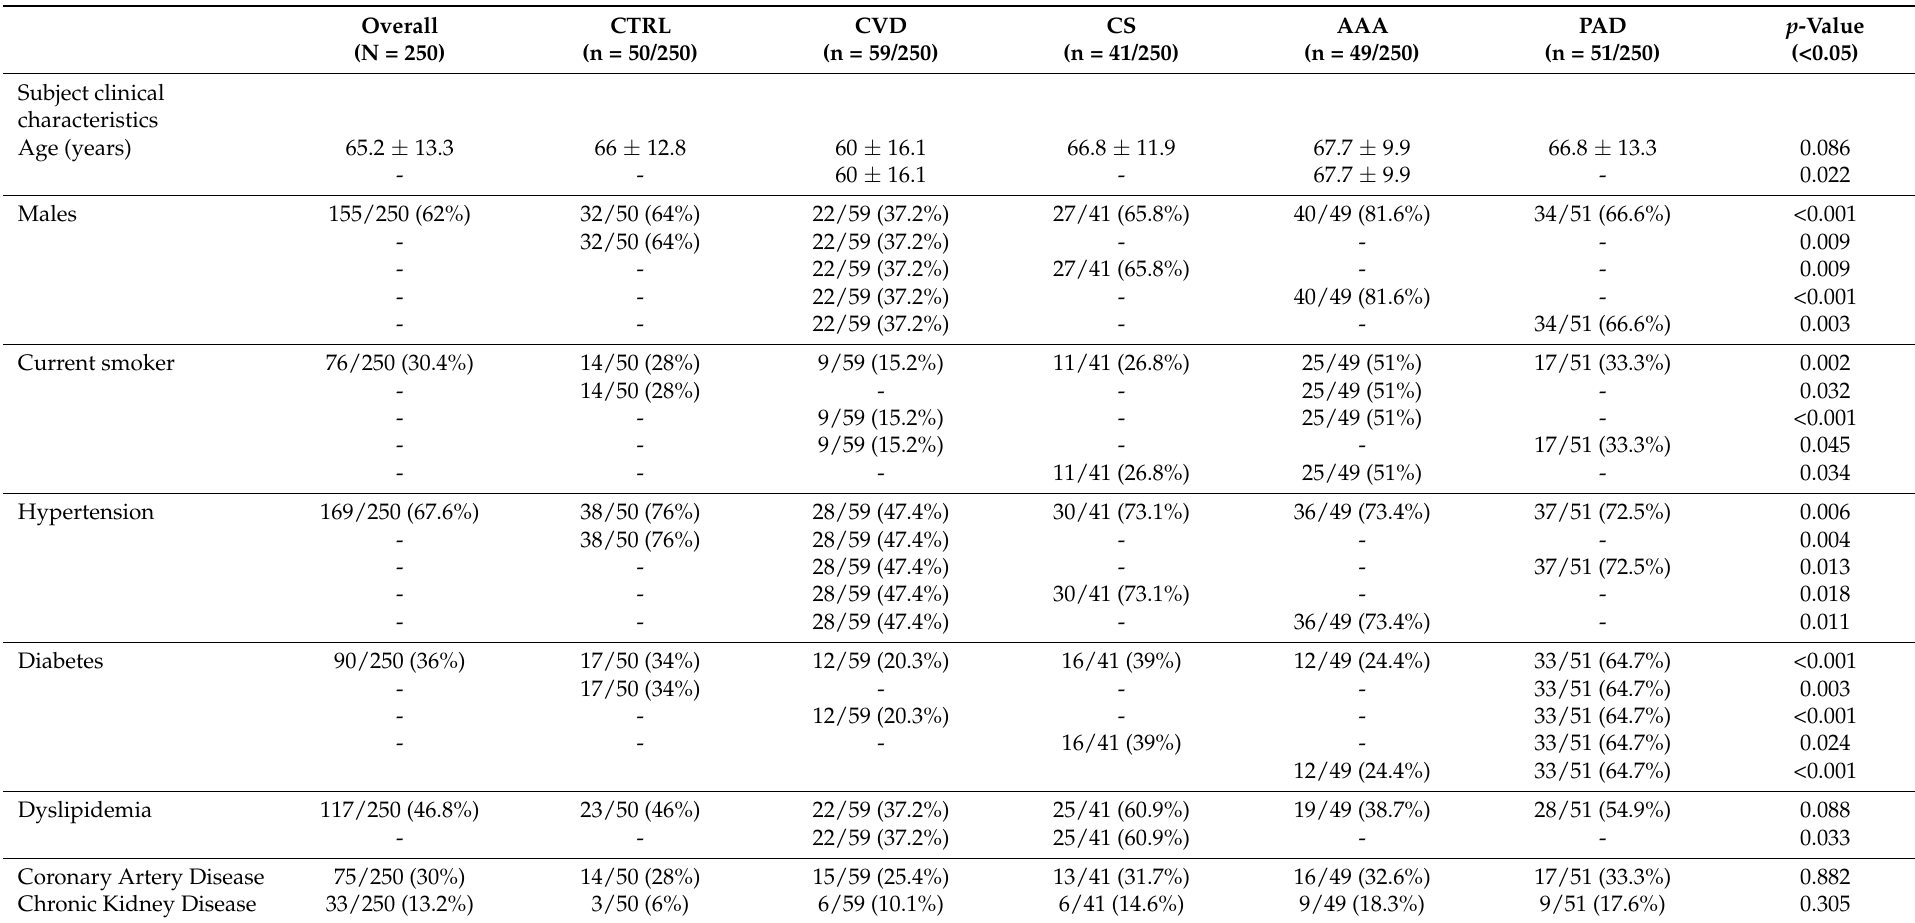
Table 1. Demographics (CTRL = control group; CVD = chronic venous disease; CS = carotid stenosis; AAA = abdominal aortic aneurysm; PAD = peripheral artery